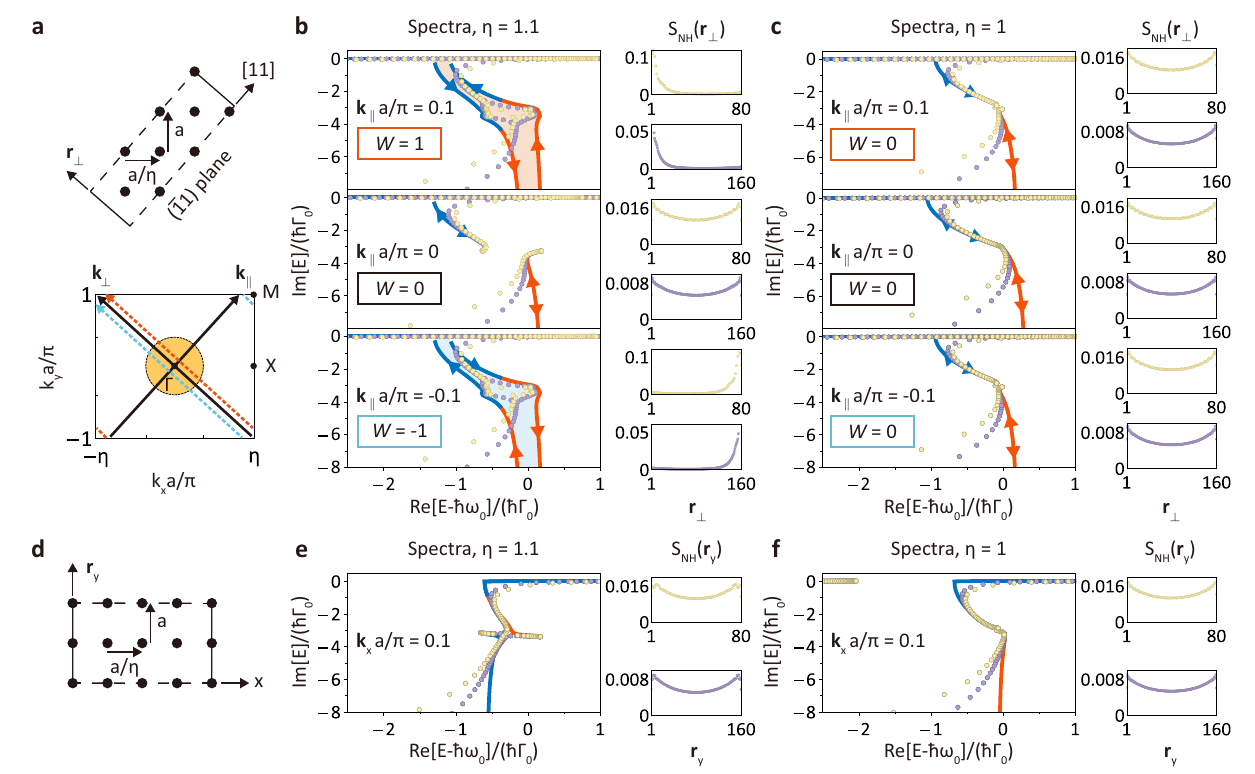
Fig. 2 | Geometry-dependent non-Hermitian skin effect in a ribbon geometry. a Illustration of the ribbon geometry for a rectangular atomic lattice. The bound- aries are open on the ð (cid:1) 11 Þ plane (dashed line) and extend in fi nitely in the [11] direction (solid line). Open boundary eigenenergy spectra σ ½ H L ð k k , r ? Þ(cid:3) of rectan- gular( b , η =1.1)andsquare( c , η =1)latticesinribbongeometrieswithawidthof80 and 160 unit cells (light yellow dots and purple dots, respectively) and the corre- sponding bulk spectra σ ½ H eff ð k k , k ? Þ(cid:3) = f E 1,2 ð k k , k ? Þg (curves in red and blue) at fi xed k ∥ =0.1 π / a (orangedashed line in a ) and k ∥ =0 ( k ⊥ axisin a )and k ∥ = − 0.1 π / a (cyan dashed line in ( a )). The non-Hermitian parts of σ ½ H eff ð k k , k ? Þ(cid:3) result in the